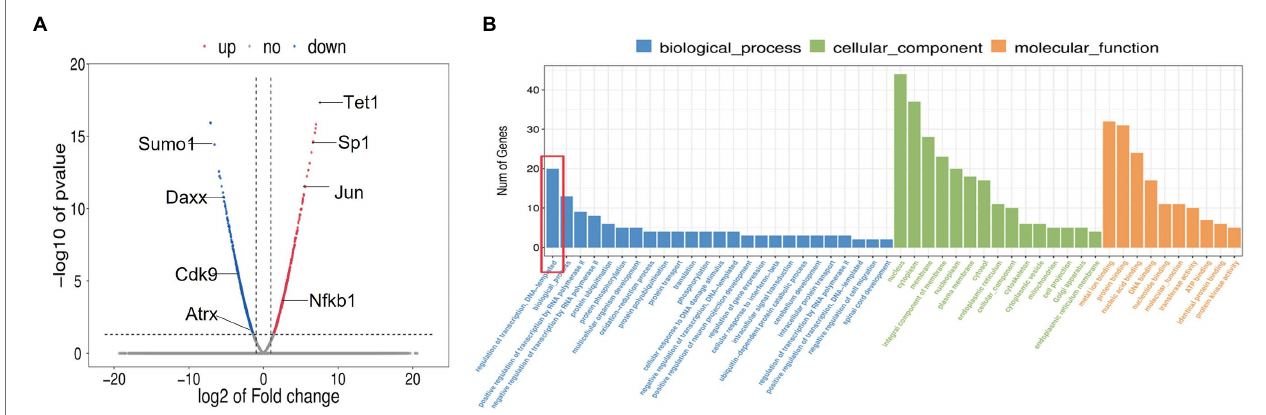
FIGURE 4 | Sequencing results of 36 h transcriptome of TET1 overexpression group and control group. (A) Transcriptome 36 h differential gene volcano map. The abscissa represents the differential expression multiple changes of genes in different samples. The ordinate represents the statistical significance of changes in gene expression levels. Red represents significantly upregulated differentially expressed genes, blue represents significantly downregulated differentially expressed genes, and gray dots represent nonsignificantly differentially expressed genes. (B) Histogram of GO enrichment of differential genes.